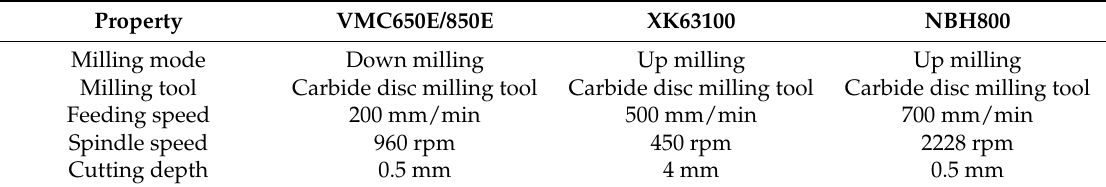
Figure 11. Milling experiment setup ( a ) VMC650E/850E; ( b ) XK63100; ( c ) NBH800; and ( d ) mobile roughness measuring instrument. Table 1. Information of the milling cutting